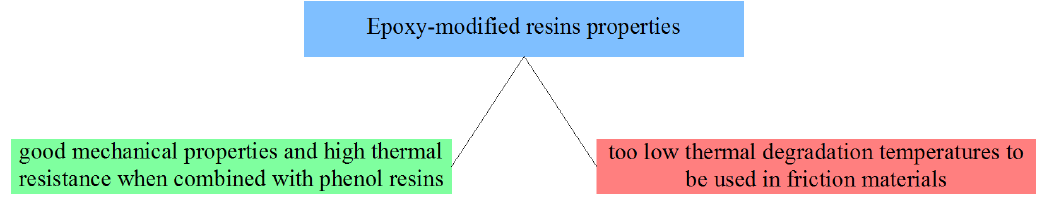
Figure 8: Selected epoxy-modified resins properties from the point of view of applicability in friction materials